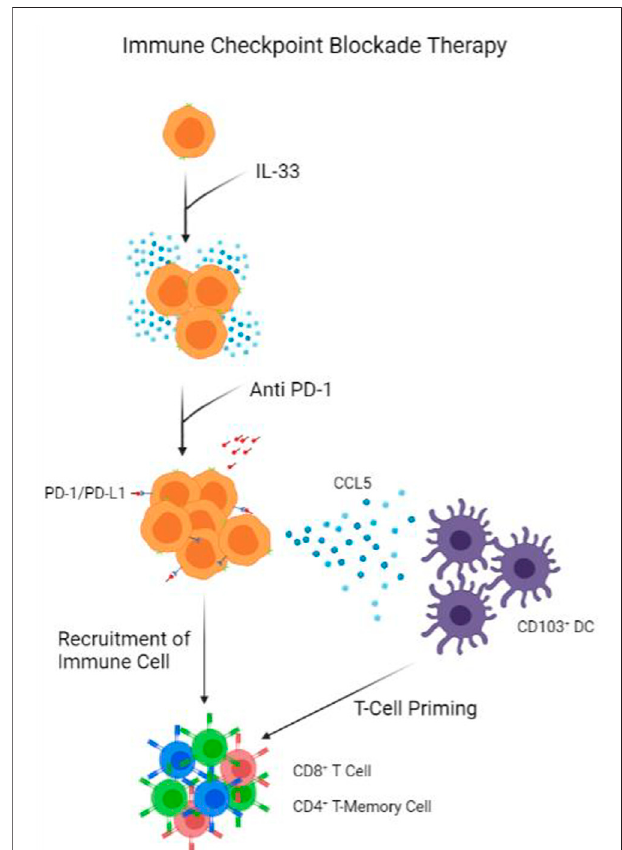
FIGURE 3 | Model of Immune Checkpoint Blockade Therapy. IL-33 presence help proliferate ILC population. Anti PD-1 antibodies block PD-1 receptorsonILCs,triggeringthereleaseofCCL5torecruitCD103 + DCs.103 + DCs prime CD8 + T-cells and CD4 + T-Memory Cells, which are recruited by ILCs into